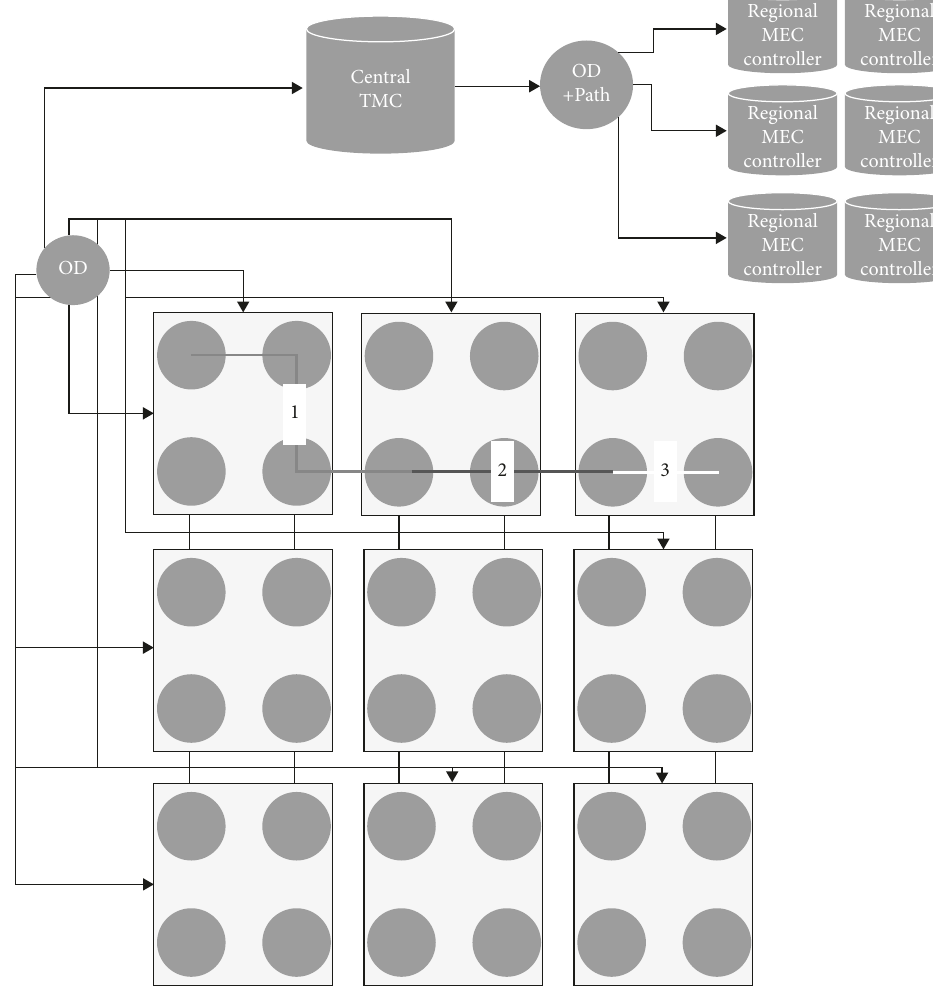
Figure 7: An example of network